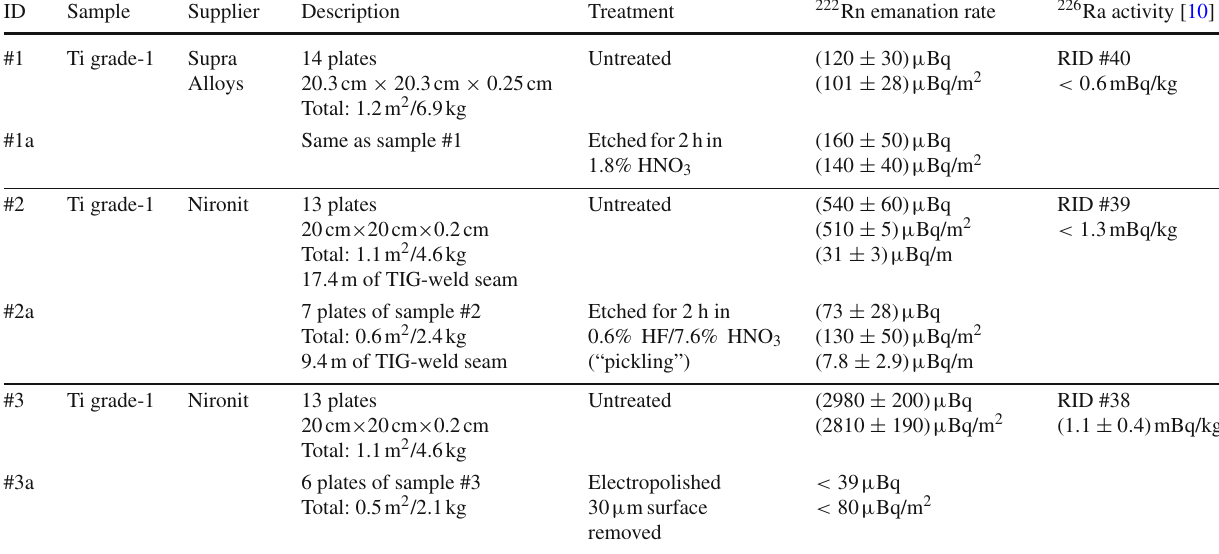
Table 1 222 Rn emanation measurements of grade-1 titanium samples. The normalization to surface area and, where relevant, to weld seam length is also given. For comparison the 226 Ra bulk activity taken from [10] is quoted and referred to as RID (Radioassay-ID) defined